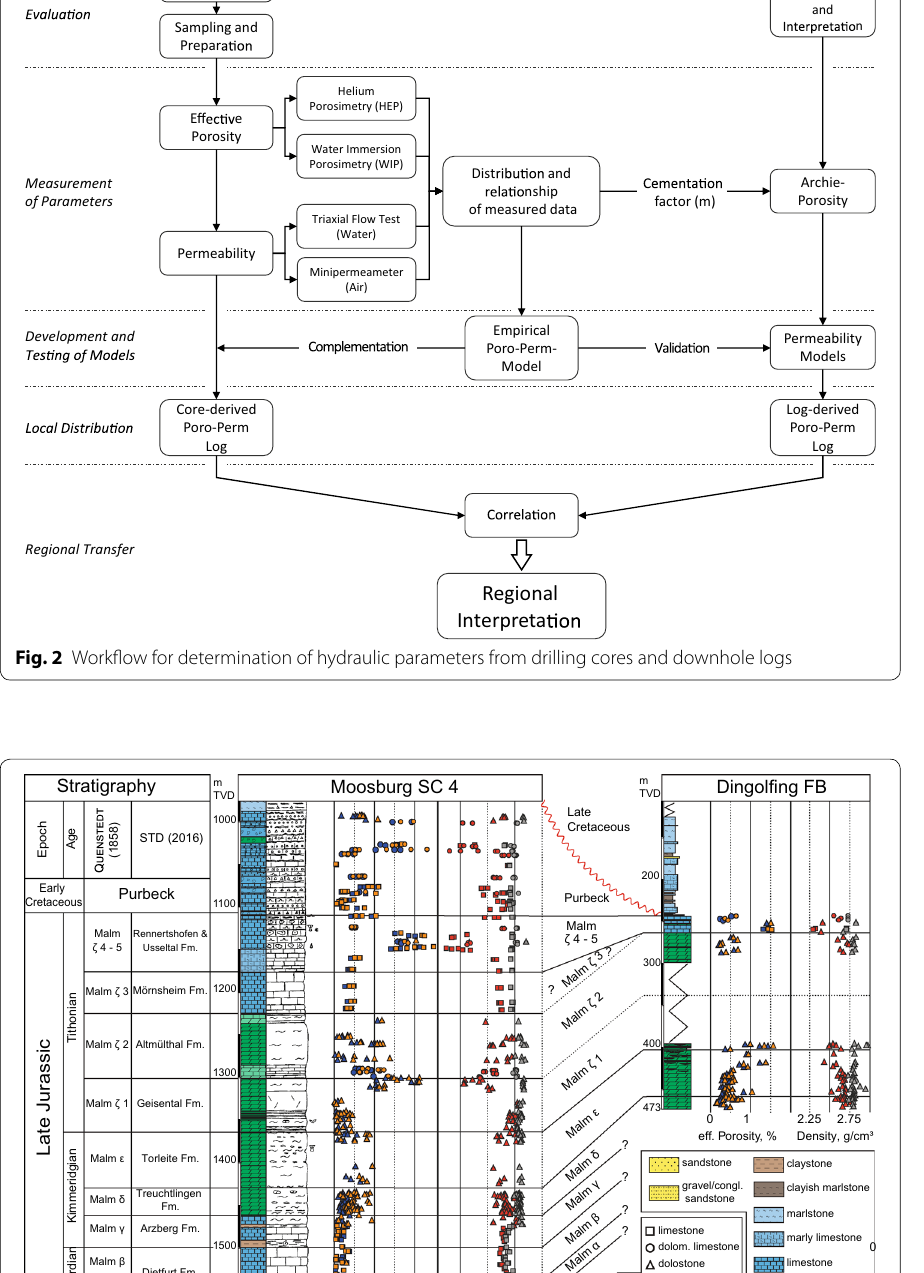
marlstoneclaystone clayish limestonemarlstone limestonemarly